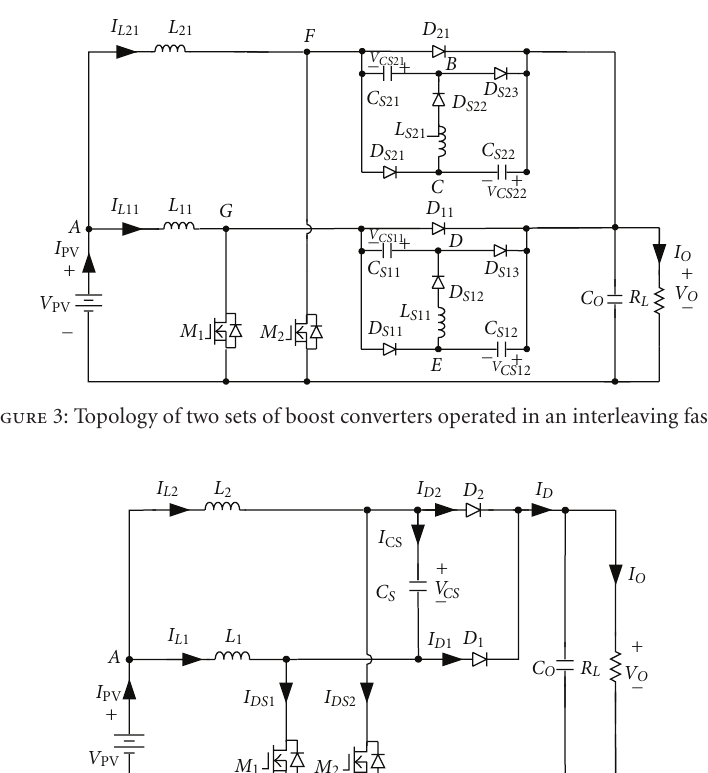
charging management. Therefore, the controller of the proposed battery charger can be divided into three